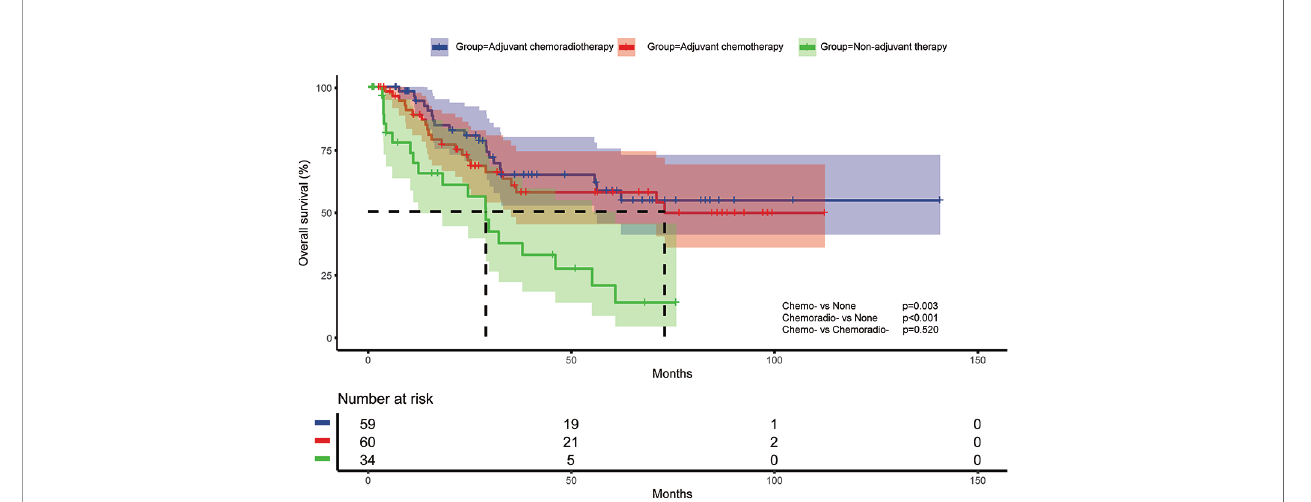
FIGURE 1 | Overall survival of different adjuvant treatment modalities in surgically resected small cell lung cancer patients.